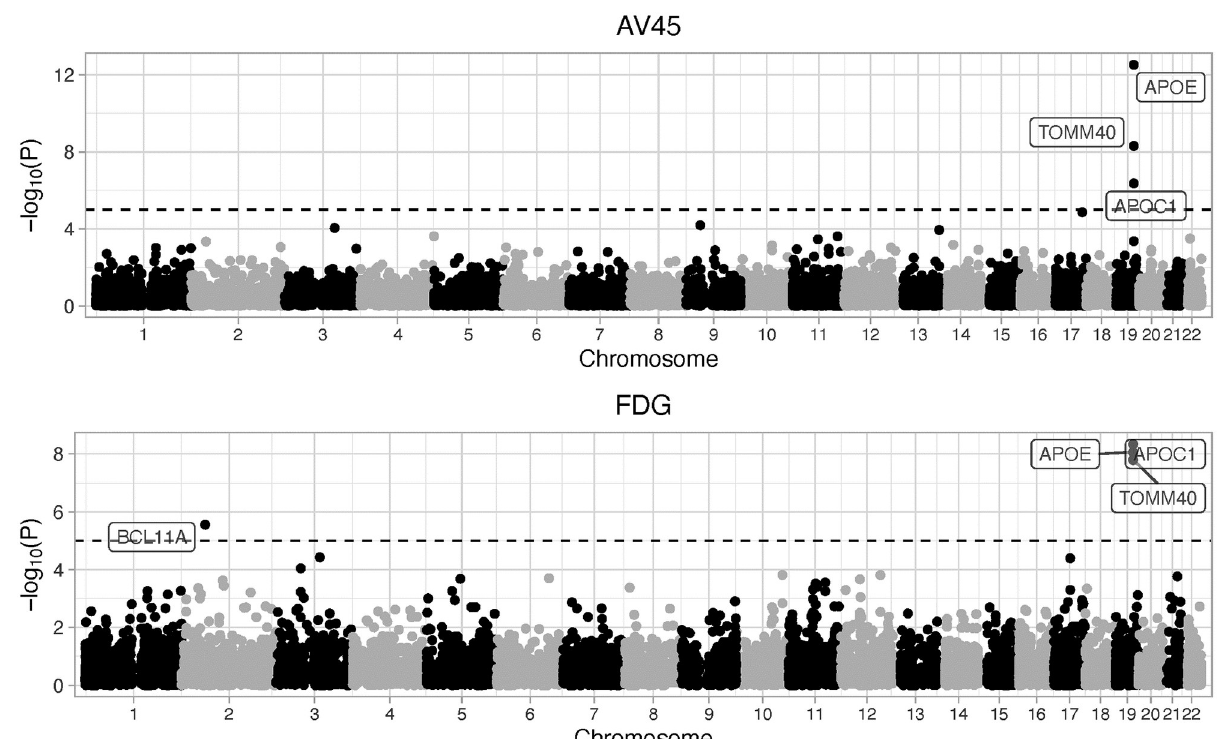
Fig 6. The Manhattan plot for AV45 and FDG using the DNN-screen